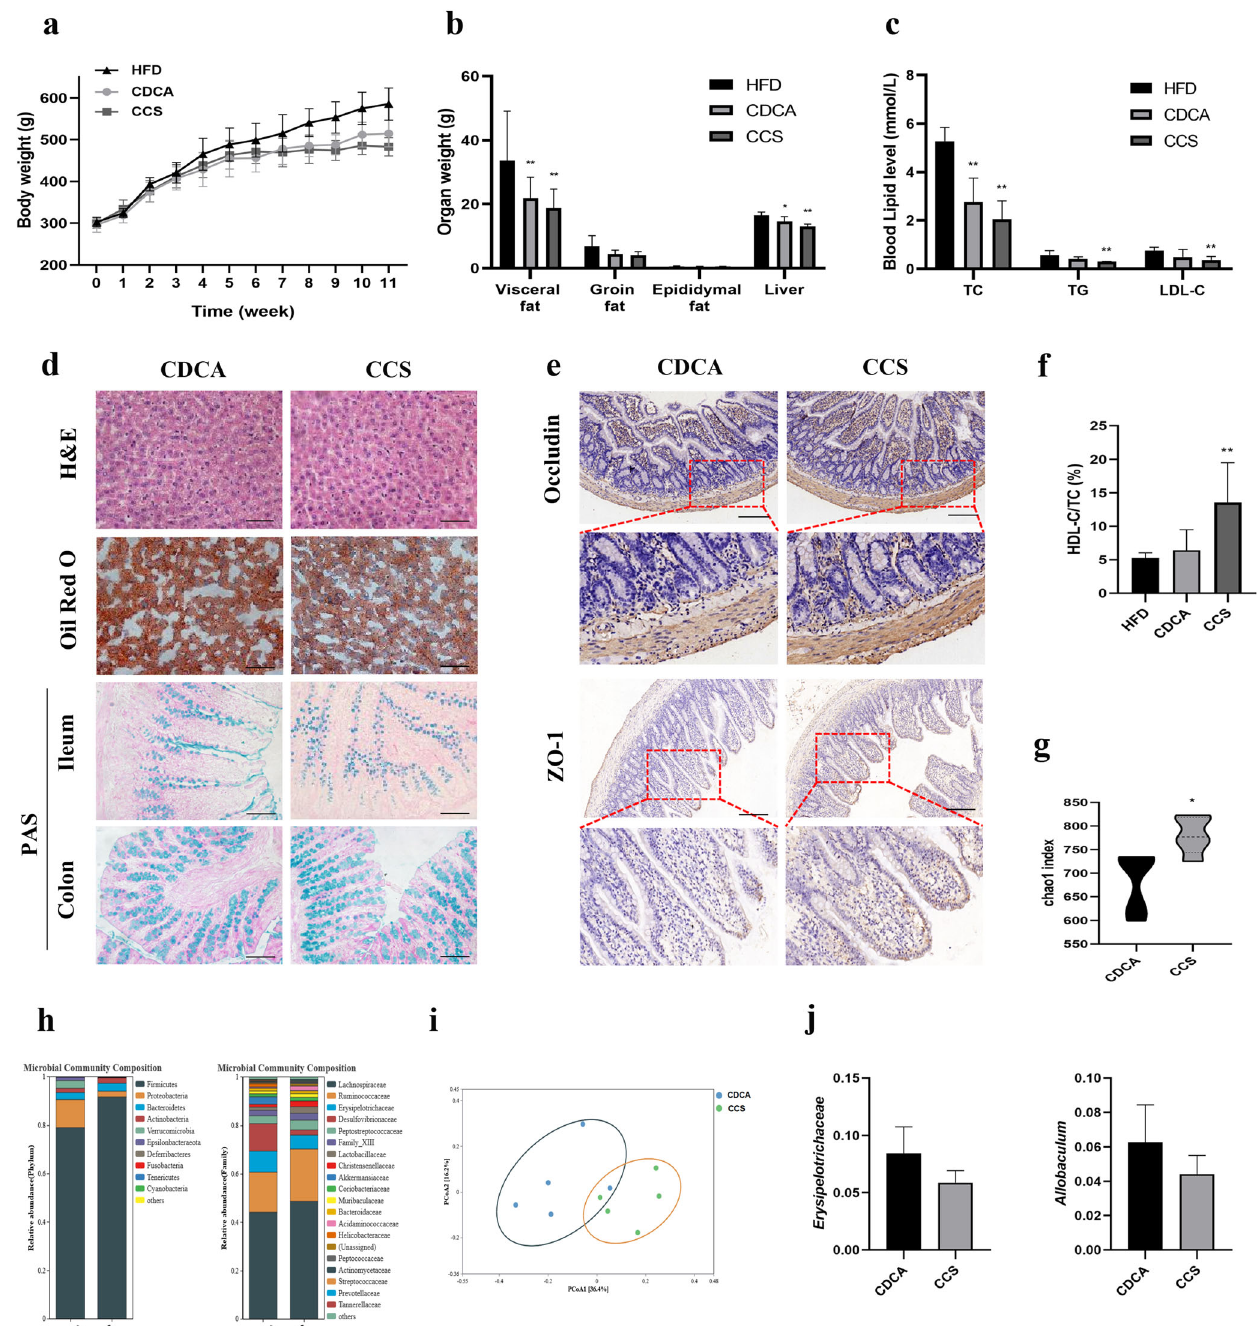
Fig. 6 CCS improved the hepatic steatosis, intestinal barrier, and altered gut microbiota in HFD fed rats. a Changes in the body weight of rats over 11 weeks; b organ weights of rats in the end of the experiment; c serum levels of lipid (TC, TG, and LDL-C); d histopathological staining of liver, ileum, and colon (H&E, ORO, and AB-PAS), Scale bar as above; e immunohistochemistry of Occludin and ZO-1 protein in ileum, Scale bar: 200 μ m; f the ratio of HDL-C/TC in serum; g the α -diversity index (chao1) of gut microbiota; h relative abundance of gut microbiota in the phylum and family level; i the β -diversity analysis (PCoA) of gut microbiota; ( j ) relative abundance of biomarker genra in the family and genus level. Data are expressed as mean±standard deviation. One-way ANOVA was used to analyze statistical differences; compared with control group, # P < 0.05, ## P < 0.01; compared with HFD group, * P < 0.05, ** P < The number of goblet cells in the ileum and colon of both groups the CDCA and CCS groups, visceral and liver weights were were upregulated. Based on the statistical results of OTU, we signi fi cantly reduced ( P < 0.05) (Fig. 6b). Levels of serum total determined the α diversity of the samples. The chao 1 index is shown cholesterol, triglyceride, and LDL-C were lower in the CCS group, in Fig. 6g. Compared to the CDCA group, CCS increased the and the ratio of HDL-C:total cholesterol was higher (Fig. 6c, f). Further, expression of Occludin and ZO-1 in the ileum using IHC (Fig. 6e). The we observed reduced vacuolation of hepatocytes and lipid load of β -diversity of the gut microbiota in the two groups is shown in the liver cells in the CCS group compared to the CDCA group (Fig. 6d).